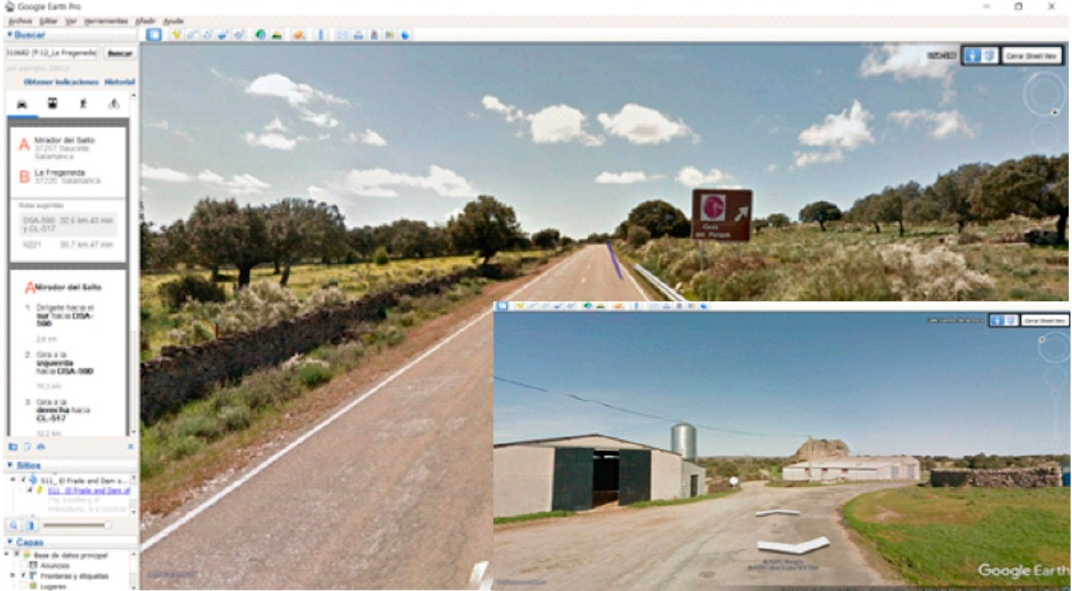
Figure 7. Capture on the selected route in “Street View” mode. Entrance to the Arribes del Duero Natural Park. Box on the left with GPS tracking. Bottom right: view of the La Peña geosite (P-7) from the route.